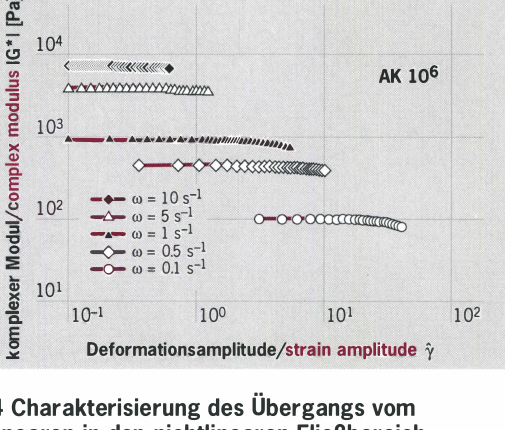
Fig. 4: Normalized complex shear modulus as a function of the strain amplitude